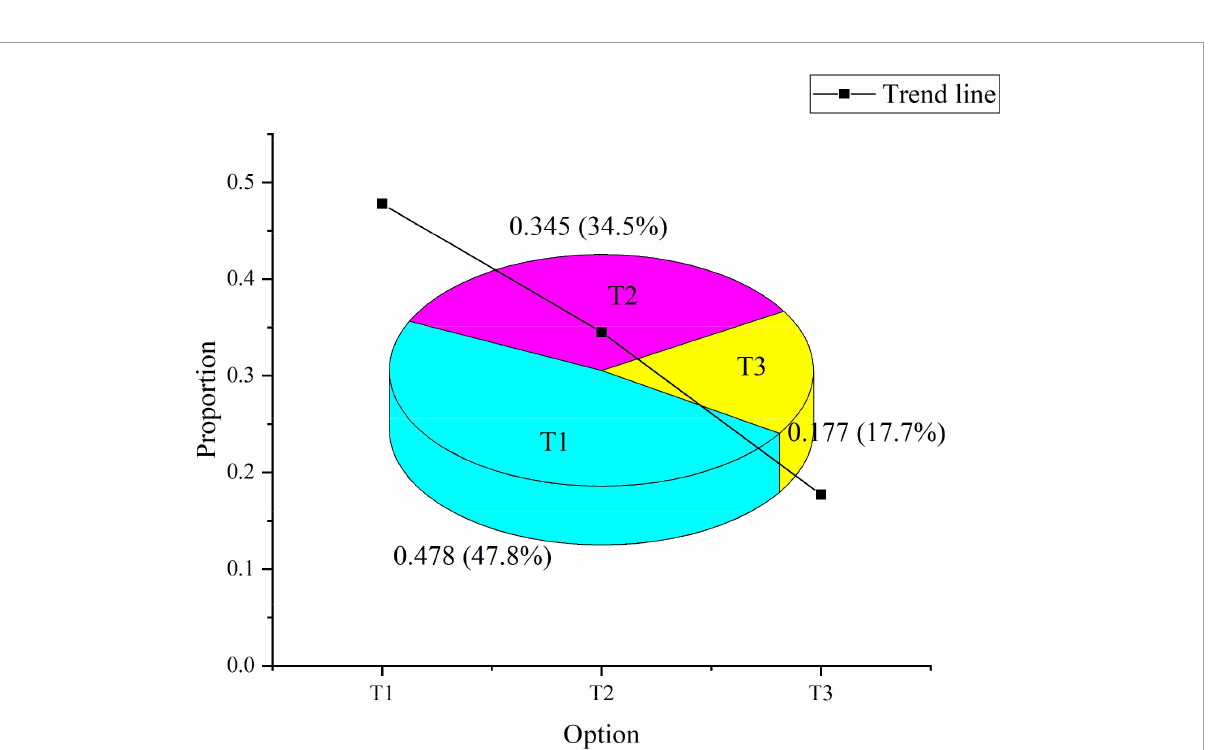
FIGURE7 Investigation of the necessity of sports culture construction. T1: the construction of sports culture is an indispensable part. T2: unnecessary. T3: it doesn’t